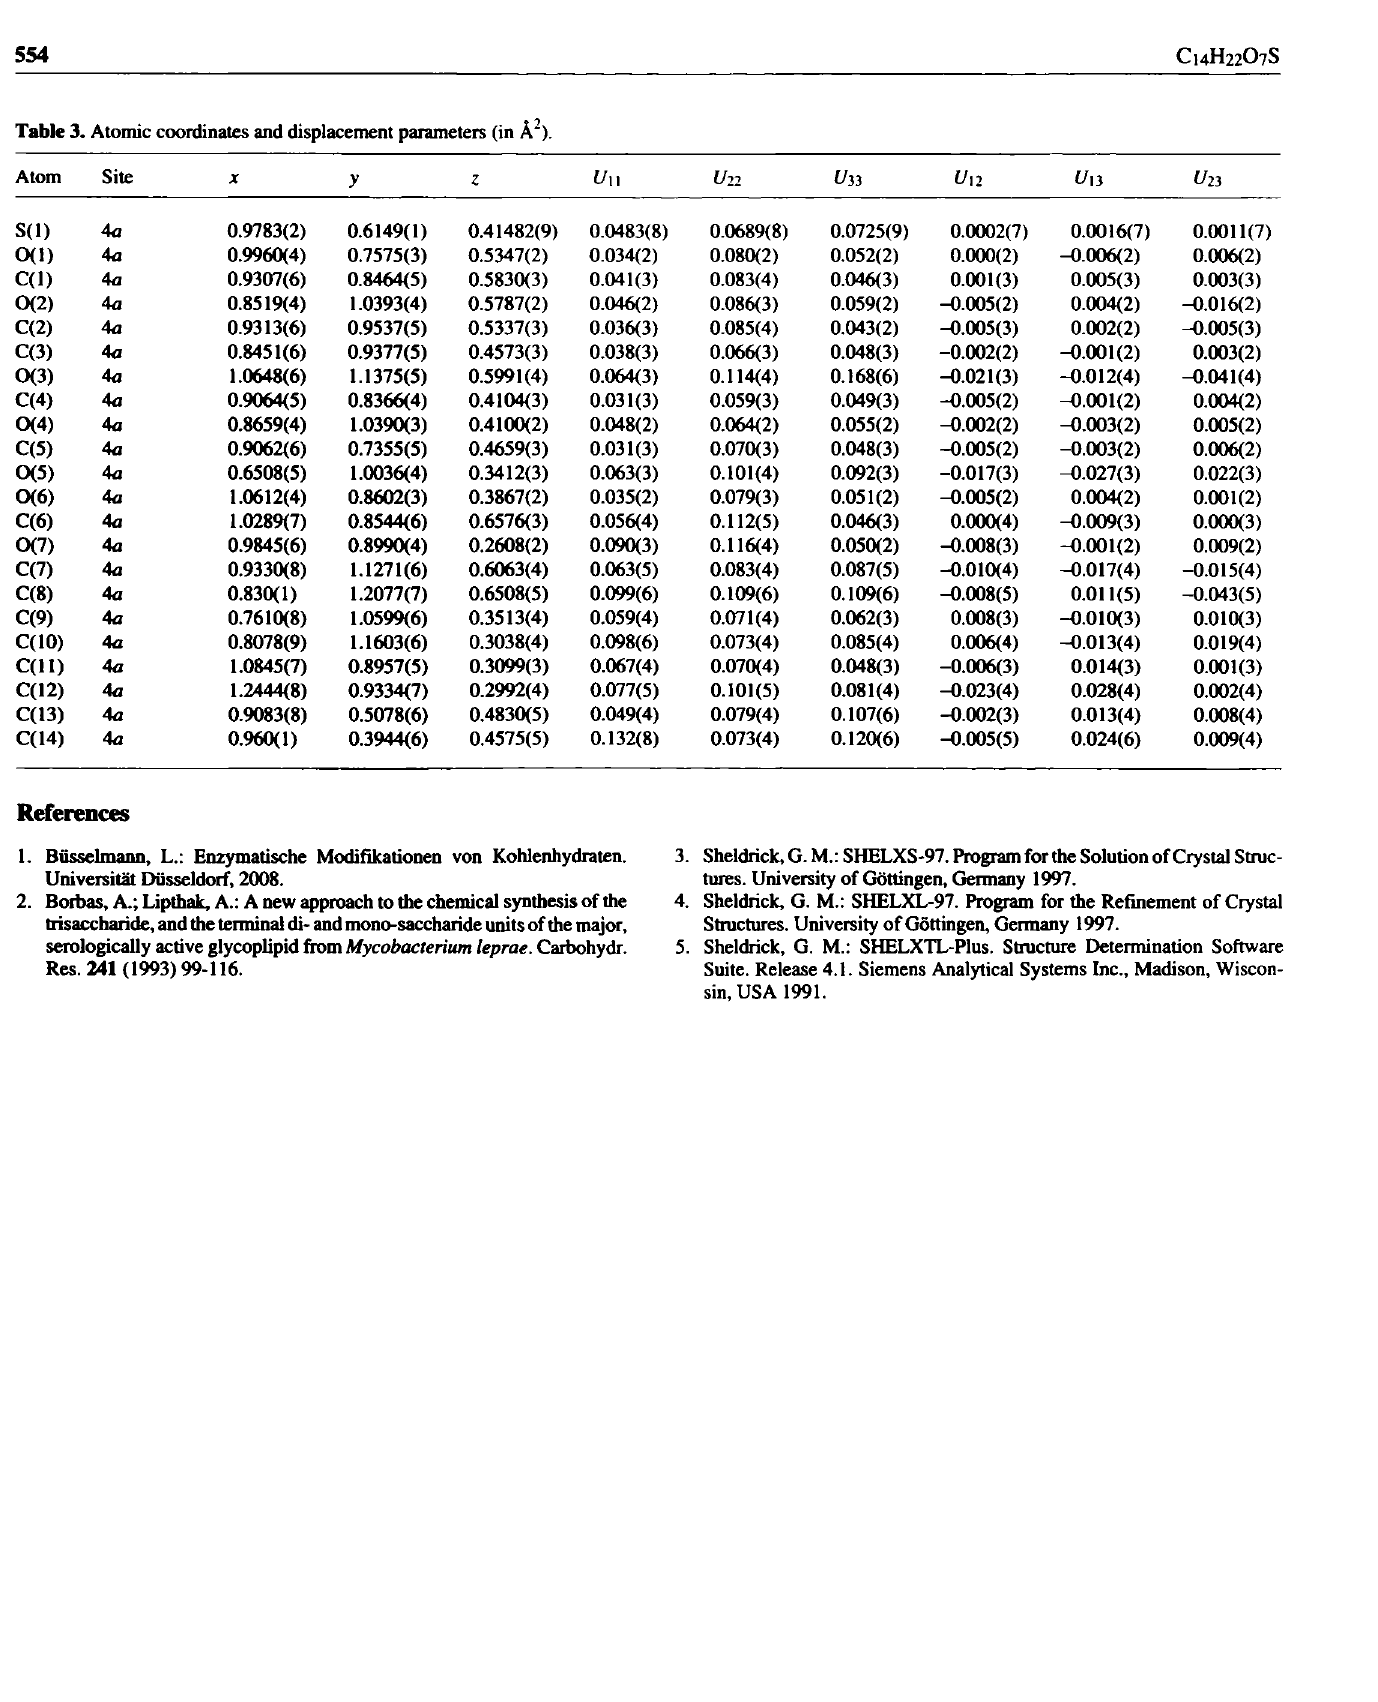
Table 3. Atomic coordinates and displacement parameters (in Â 2